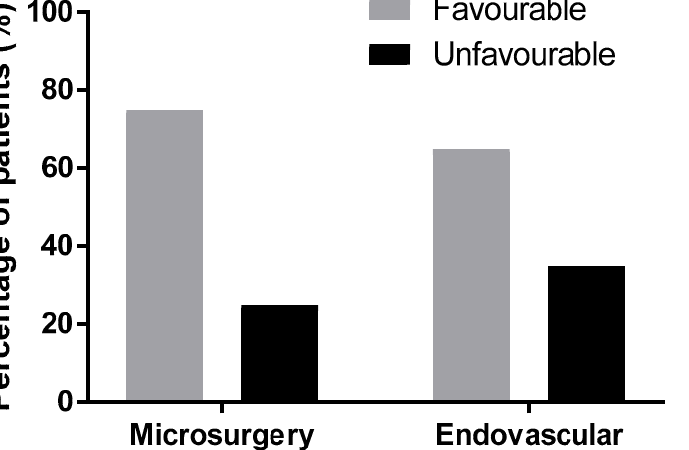
Figure 3. The di ff erence between outcomes of surgery and endovascular treatment lacks statistical significance ( p = 0.165); Glasgow Outcome Score after three